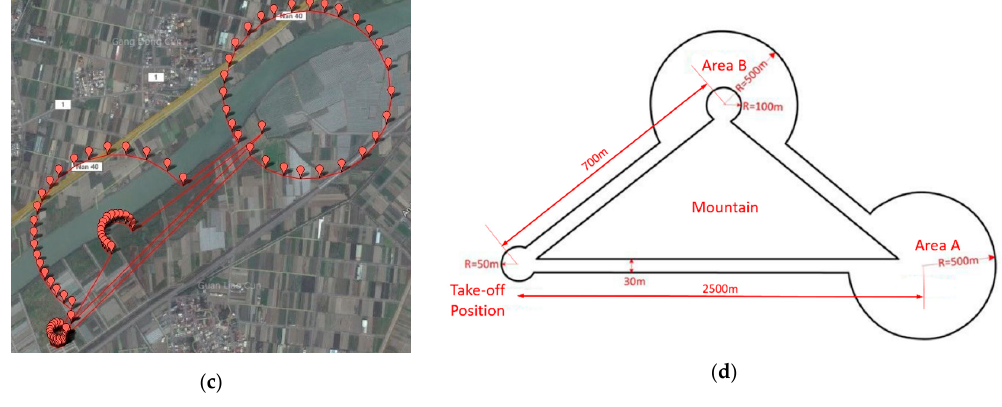
Figure 20. ( a ) Test route in Hong Kong; ( b ) schematics of the designed route in Hong Kong; ( c ) search areas A and B for blind tests in Taiwan and ( d ) schematics of the designed search route and areas in Taiwan.